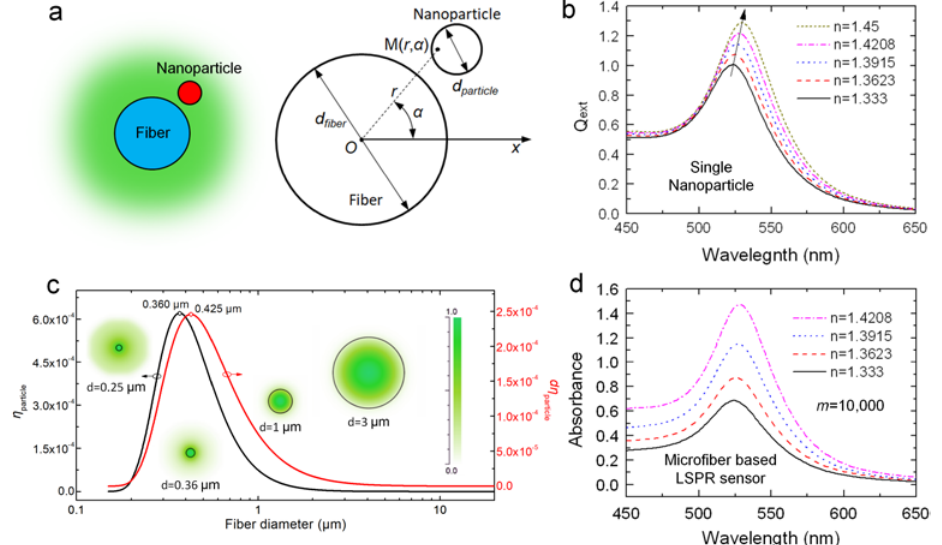
Figure 2. ( a ) Schematic diagram of the model; ( b ) Extinction of a 20 nm-sized gold nanoparticle with different surrounding refractive indexes (RIs); ( c ) Calculated η particle and d η particle of a 20 nm-sized nanoparticle located on the surface of a OMNF as a function of fiber diameter (wavelength: 520 nm); ( d ) Simulated spectral responses of a OMNF-based LSPR sensor to different surrounding RIs ( d fiber = 1 µm, d particle = 20 nm, m = 10,000, wavelength: 520 nm).